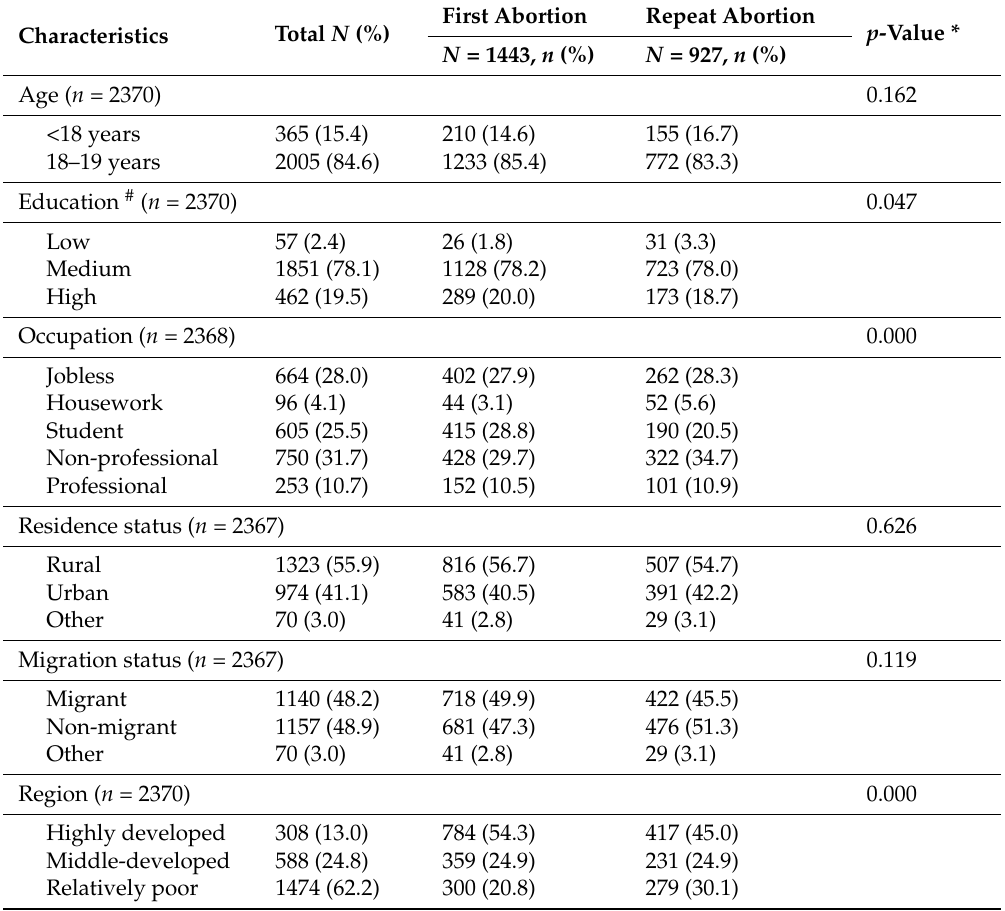
Table 1. Sociodemographic characteristics of adolescents receiving abortions by history of